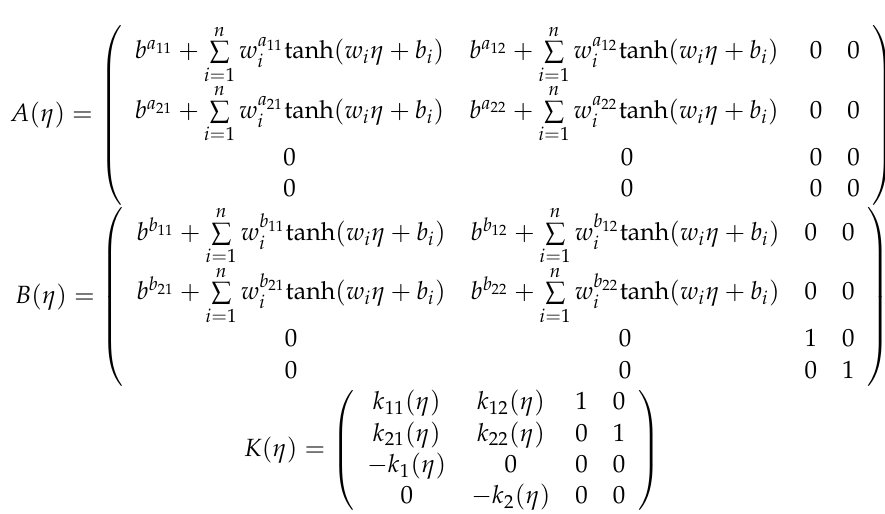
Table 1. The values of the parameters of the dynamic model of the gas turbine engine [13]. Vector of the Model No. Coefficients